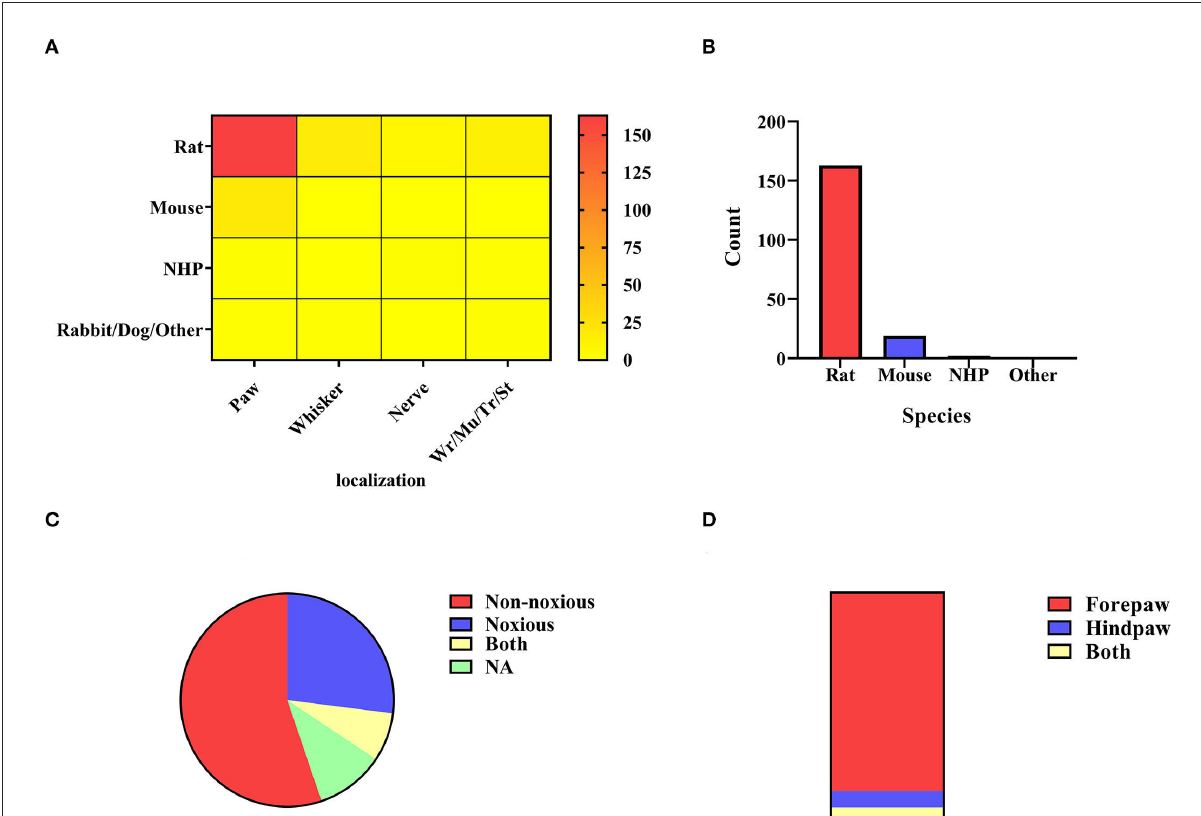
FIGURE3 (A) Electrical stimulation localization. All electrical stimulation is classified according to the localization of stimulation, including paw stimulation (n = 183, 82.43%), whisker stimulation (N = 15, 6.76%), nerve stimulation (n = 9, 4.05%), and others (n = 15, 6.76%) including muscle, stomach, trunk, wrist. The color bar means the number of studies. (B) Paw stimulation. The species distribution of paw stimulation is rat (n = 161, 87.98%), mouse (n = 19, 10.38%), non-human primate (n = 2, 1.09%), and NA (n = 1, 0.55%). (C) Rats’ paw stimulation. Noxious stimulation <2mA (n = 42, 26.09%) and non-noxious stimulation ≤ 2m (n = 90, 55.90%). Some experiments covered both stimulus intensities (n = 12, 7.45%), and different stimulus intensities were adopted in the remaining chapters, or no specific description was given (n = 17, 10.56%). (D) Rats’ paw localization. A bar graph was obtained by distinguishing the sites of stimulation by the forepaw (n = 141, 87.58%), the hind paw (n = 12, 7.45%), and both (n = 8,